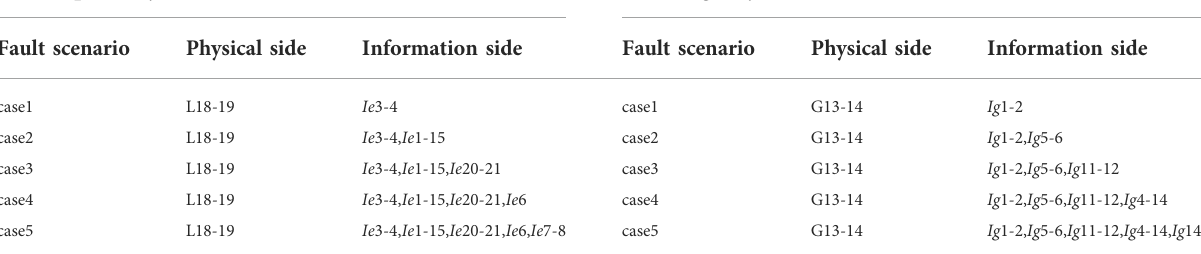
TABLE 1 Failure scenario